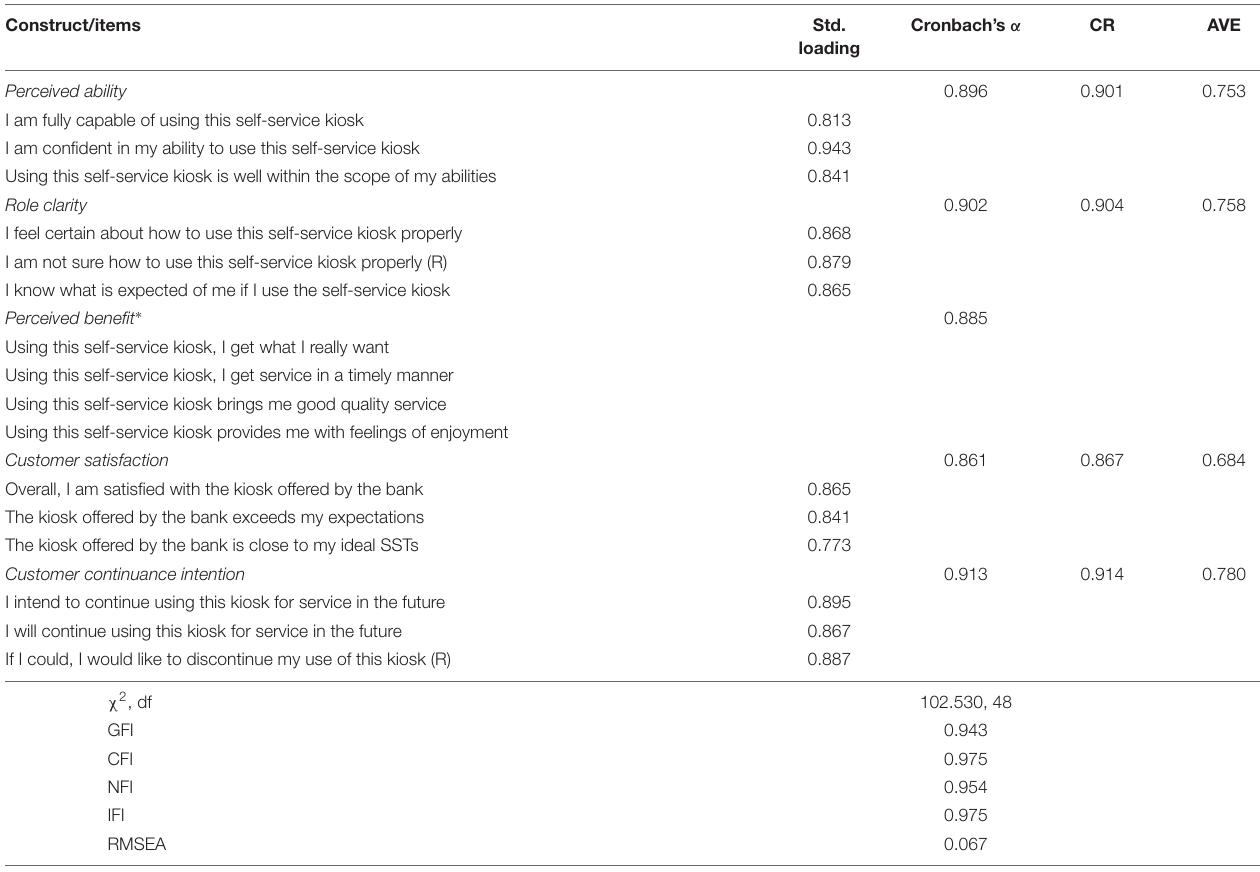
TABLE 2 | Measures and results of the measurement model.